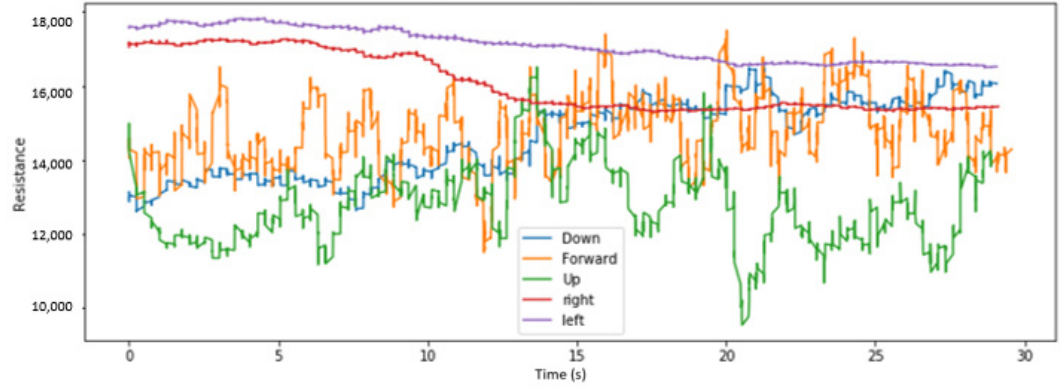
Figure 9. With long sensor, head tilt filtered data, with right and left tilts added.